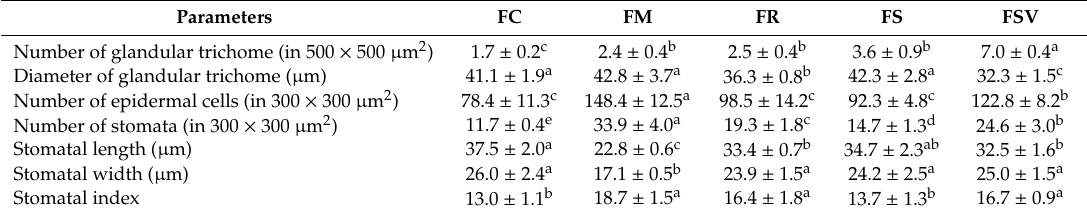
Table 1. Anatomical characteristics of the lower leaf surface of Fraxinus plants.